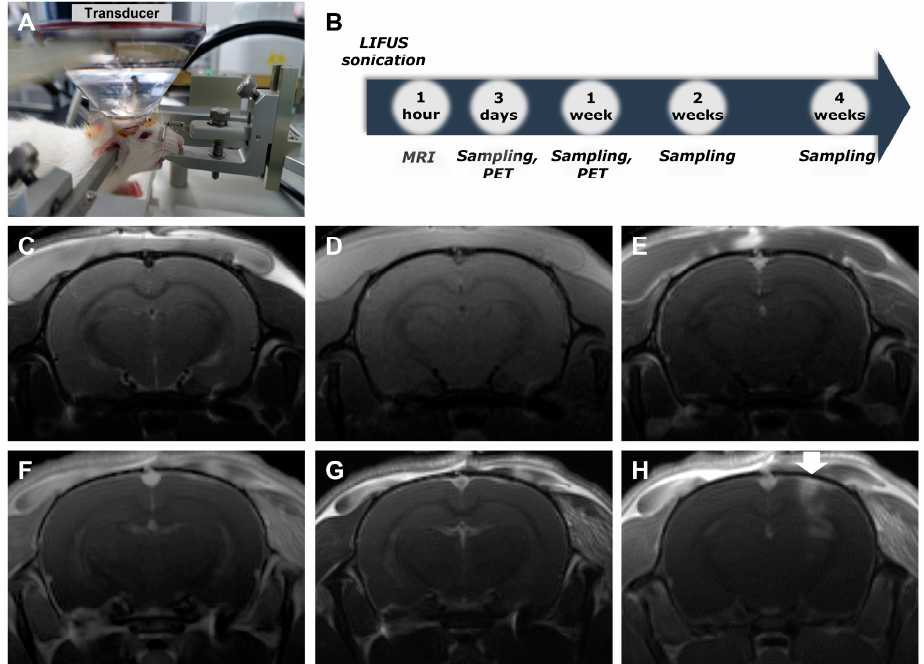
Figure 1. Confirmation of LIFUS-induced BBB modulation by MRI imaging. ( A ) FUS experimental system setup. ( B ) Timeline of the experiment for comparison at 3 days, 1 week, 2 weeks, and 4 weeks after sonication. ( C ) T2-weighted image of non-treated rats. ( D ) T1-weighted image of non-treated rats. ( E ) Gadolinium-enhanced T1-weighted image of non-treated rats. ( F ) T2-weighted image of treated rats. ( G ) T1-weighted image of treated rats. ( H ) Gadolinium-enhanced T1-weighted image of treated rats. Arrow: modulated area of LIFUS. BBB, blood–brain barrier; LIFUS, low-intensity focused ultrasound; MRI, magnetic resonance imaging; PET, positron emission